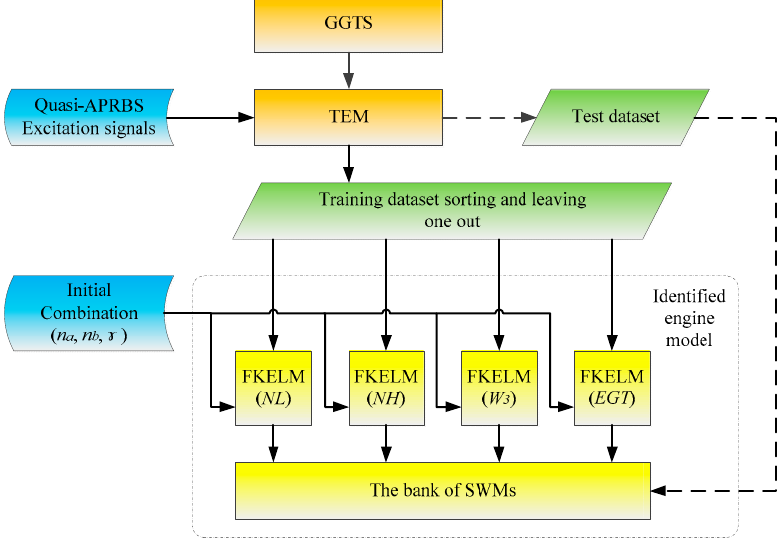
Figure 3. The procedure schematic of the methodology for aircraft engine identification.